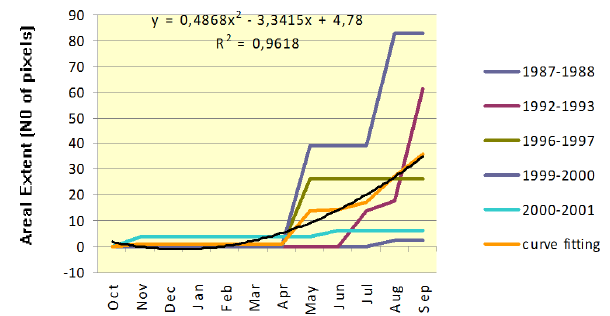
Fig. 5. Cumulative small areal extent (number of pixels 8X8 km2) of extreme drought ( > 2.0) during drought years based on remotely Figure 5. Cumulative Small Areal Extent (No of pixels 8X8 km2) of extreme drought (>2.0) 34 sensed during drought years based on remotely sensed RDI. 35 36